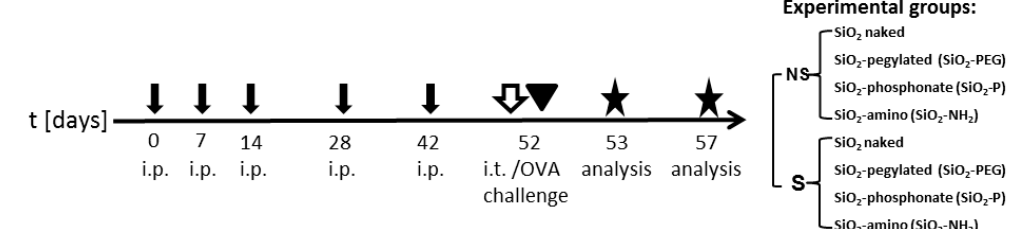
Figure 3. Experimental protocol. BALB/c mice were intraperitoneally sensitized (S) with OVA/aluminum hydroxide or non-sensitized (NS) with phosphate-buffered saline/aluminum hydroxide (black arrows). On day 52, S and NS mice were intratracheally instilled with SiO 2 nanoparticles or with CTL supernatant (white arrow) and subsequently challenged with OVA aerosol (arrowhead). Gene expression in pulmonary tissue was analyzed on day 57. Experimental groups are